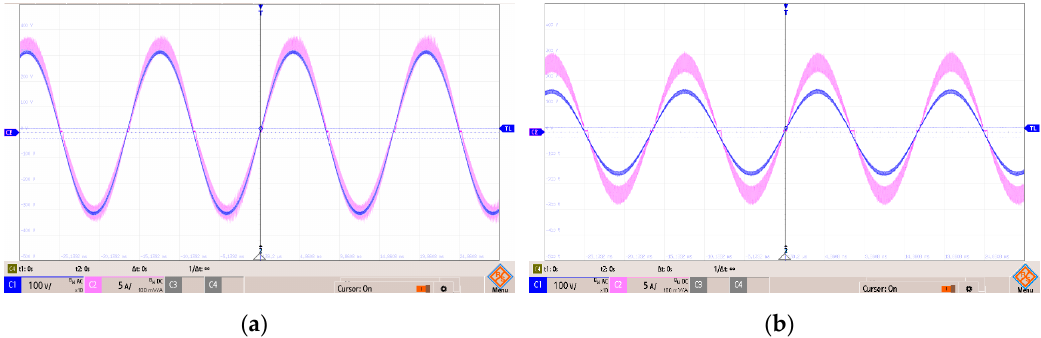
Figure 10. Experimental waveforms of the totem-pole PFC rectifier running ( a ) at 230 VAC input and 2.6 kW output load; ( b ) at 115 VAC input and 1 kW output load (for both left and right figures: V AC 100 V/division, channel 1– I L 5 A/division, channel 2. Timebase 5 ms/division).